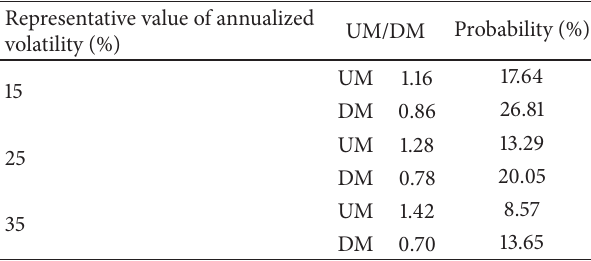
Figure 3: The trend of the futures and spot prices of copper between 2007 and 2015.